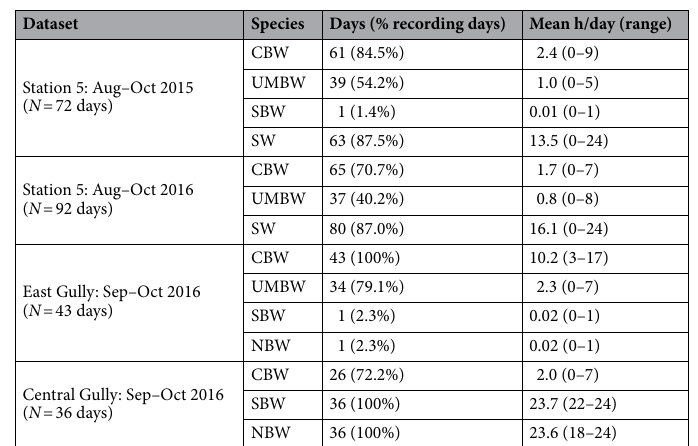
Table 1. Summary of the number of days (percent of recording days) and mean number of hours per day (range: minimum–maximum) with echolocation clicks from Cuvier’s beaked whales (CBW), unknown Mesoplodont beaked whales (UMBW), Sowerby’s beaked whales (SBW), sperm whales (SW), and northern bottlenose whales (NBW) in each dataset analyzed.